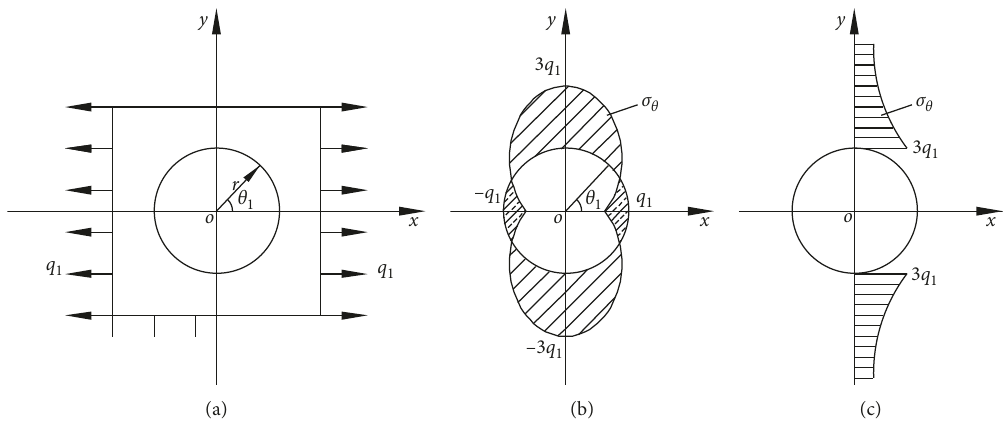
Figure 1: The diagram of stress concentration on the hole wall of the empty hole due to the longitudinal wave. (a) Empty hole subjected to uniformly distributed horizontal forces. (b) Hole wall stress. (c) Hole edge